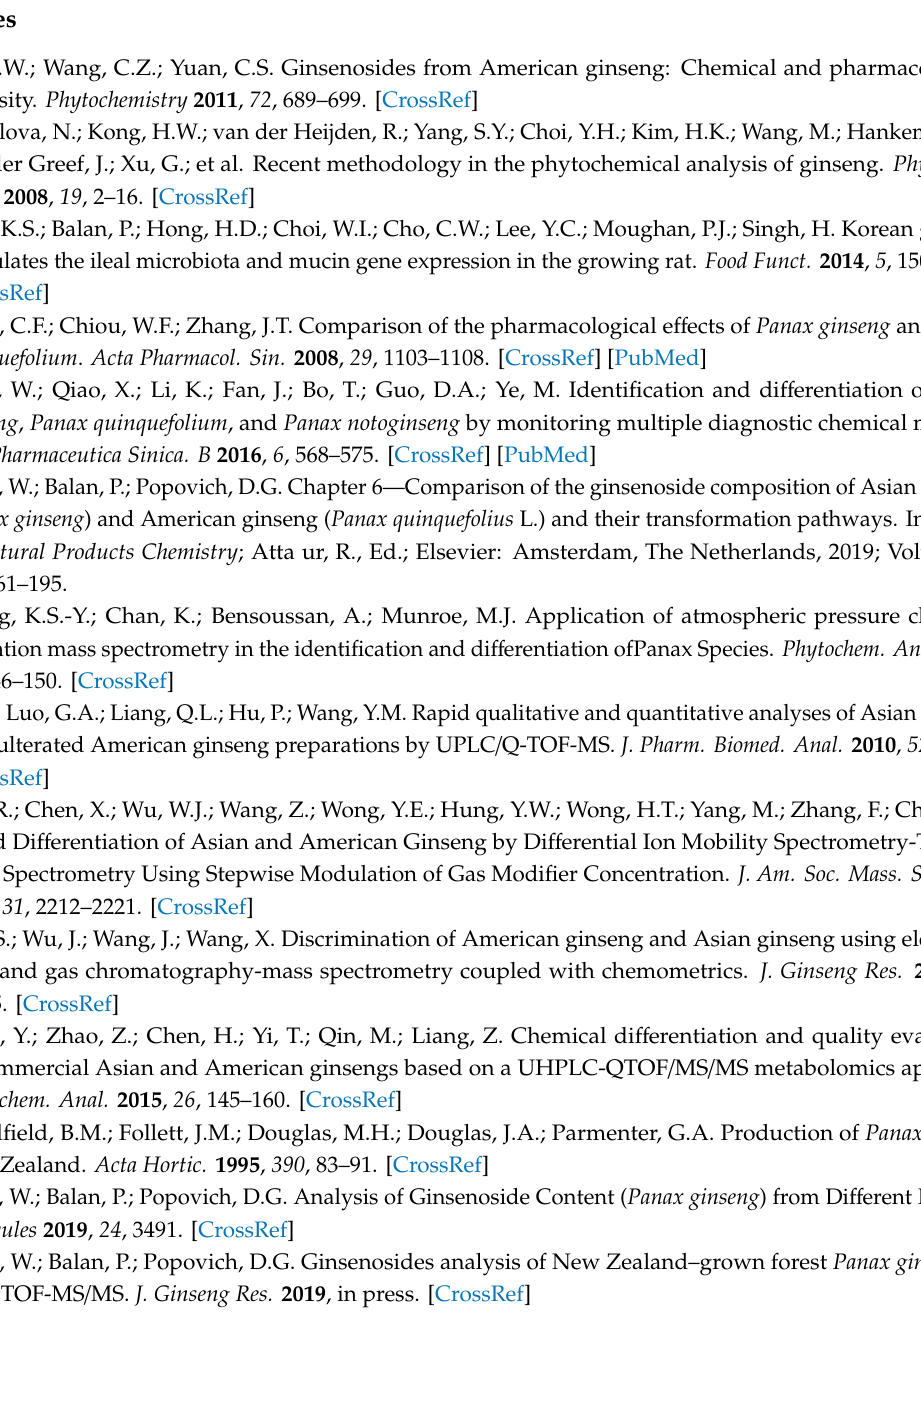
Table S1: The regression equations, linear ranges, limits of detection and limits of quantification of 14